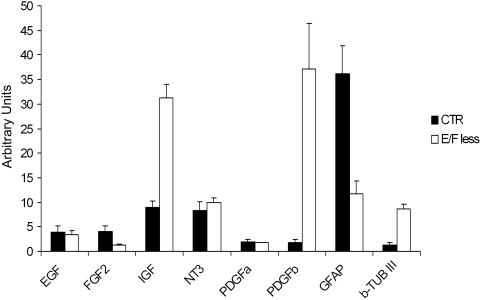
Gene expression profile before and after growth factor starvation in hNPC.After 14 days growth factors withdrawal, hNPC decreased the expression of fgf-2 and gfap and increased the expression of igf-1 and pdgfb. hNPC also showed an increase in β-tubulin III expression. We show the mean relative expression of two independent reactions calculated as described in methods with the propagated Cq standard deviations. Primer sequences are listed in Table S1.